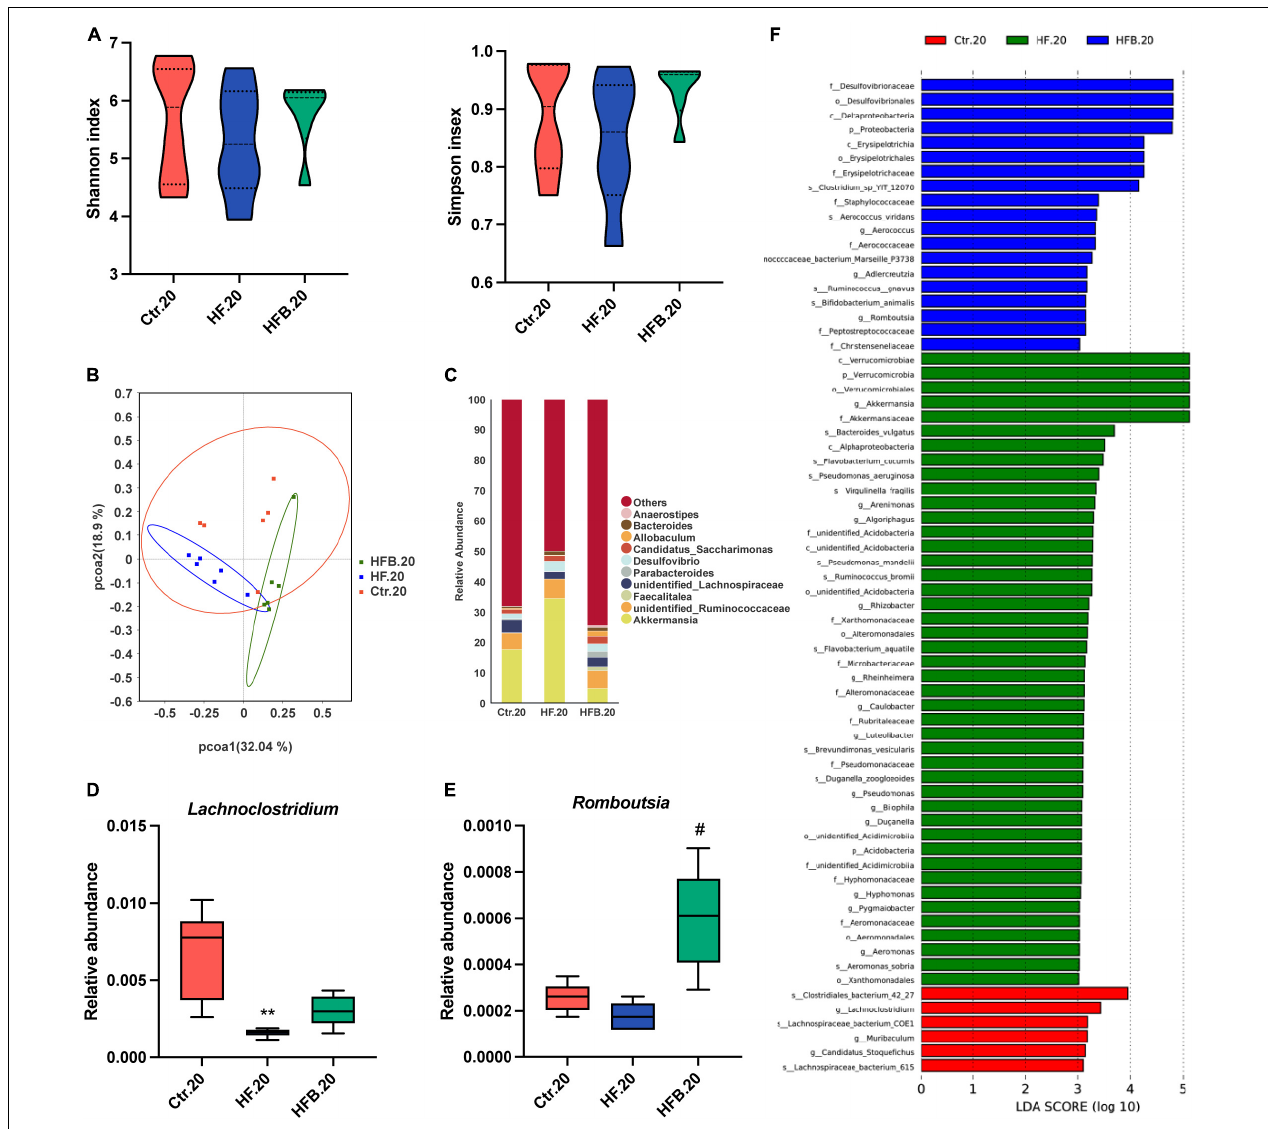
FIGURE 6 | Maternal betaine alters the gut microbiota in early-life high-fat diet offspring at 20 weeks of age. The cecal contents were collected from offspring at 20 weeks of age. (A) Shannon index (left) and Simpson index (right); (B) PCoA plots of gut microbiome; (C) relative abundance of the top 10 species at the genus level; (D) relative abundance of Desulfovibrio ; (E) relative abundance of Romboutsia ; (F) distinct taxa identified in the three groups using LEfSe analysis. The colors represent the group in which the indicated taxa is more abundant compared to the other group. Ctr.20, 20-week-old offspring of dams fed with the standard control diet; HF.20, 20-week-old offspring of dams fed with the high-fat diet; HFB.20, 20-week-old offspring of dams fed with the high-fat diet with betaine. Data are expressed as means ± S.E.M. ( n = 5–6/group). One-way ANOVA; ** p < 0.01 vs. Ctr, # p < 0.05 vs.